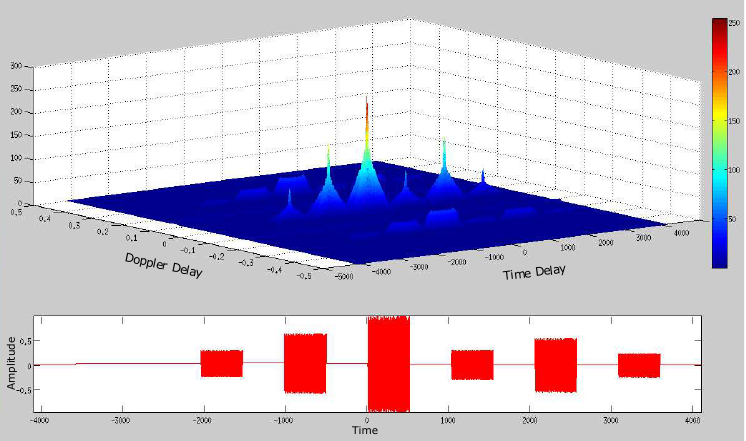
Figure 29. Multiple object tracking using MMPP “chirp pulses”, at Tracking Time 3, with no noise.